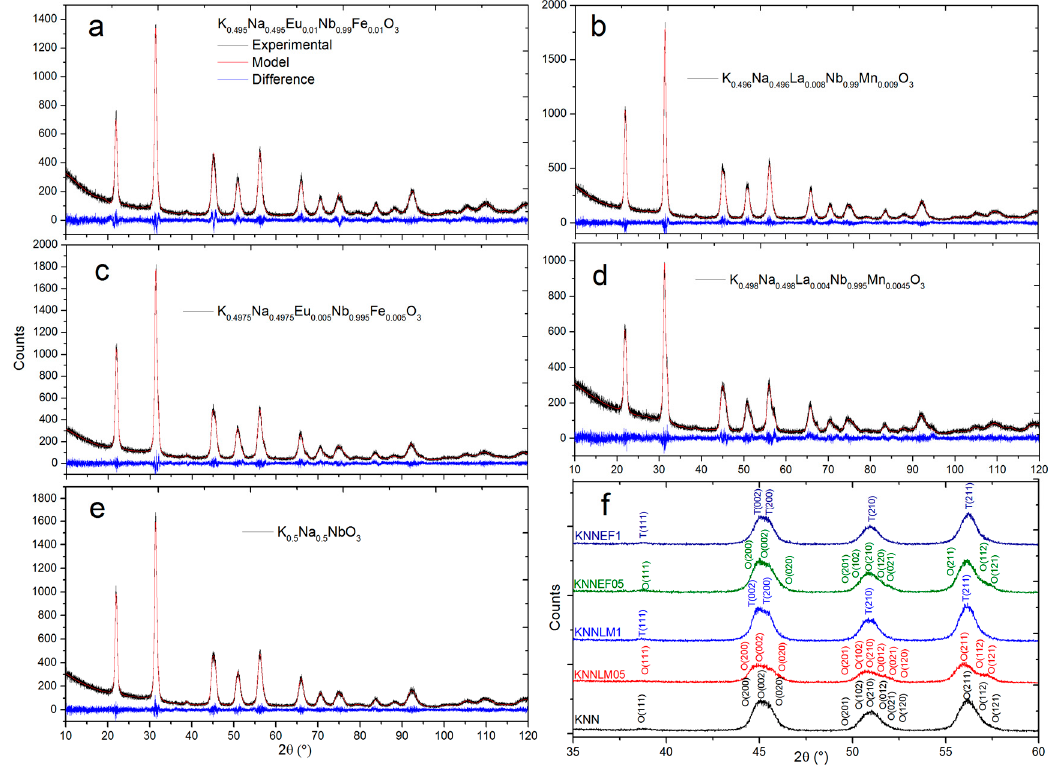
Figure 1. Experimental XRD patterns and results of their Rietveld refinement. ( a ) (K 0.5 Na 0.5 ) 0.990 Eu 0.010 Nb 0.990 Fe 0.010 O 3 ; ( b ) (K 0.5 Na 0.5 ) 0.992 La 0.008 Nb 0.990 Mn 0.0090 O 3 ; ( c ) (K 0.5 Na 0.5 ) 0.995 Eu 0.005 Nb 0.995 Fe 0.005 O 3 ;